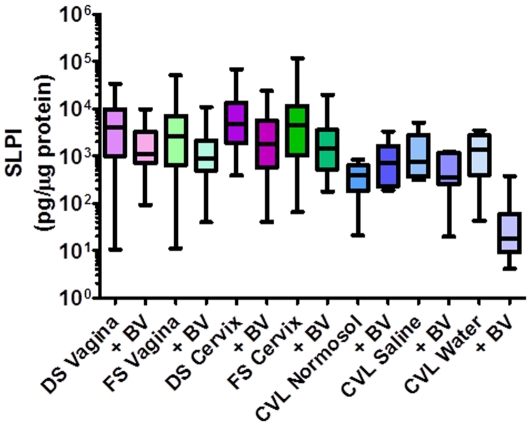
Levels of secretory leukocyte protease inhibitor (SLPI) in female genital tract secretions collected by swabs and cervicovaginal lavages (CVL) in women without or with bacterial vaginosis (BV).Female genital tract secretions were collected by Dacron swabs (DS) and flocked swabs (FS) from the vagina and the endocervix (cervix) and by CVL using Normosol-R, saline, or water. Women with BV (n = 24) had a Nugent score of ≥7. Data are presented as box and whisker plots where the median is the horizontal line through the vertical box which represents the 25–75th percentiles. Values within the 10–90th percentiles are represented by the error bars. Data were log-transformed and significant changes were determined using linear mixed model and discussed in the results section.